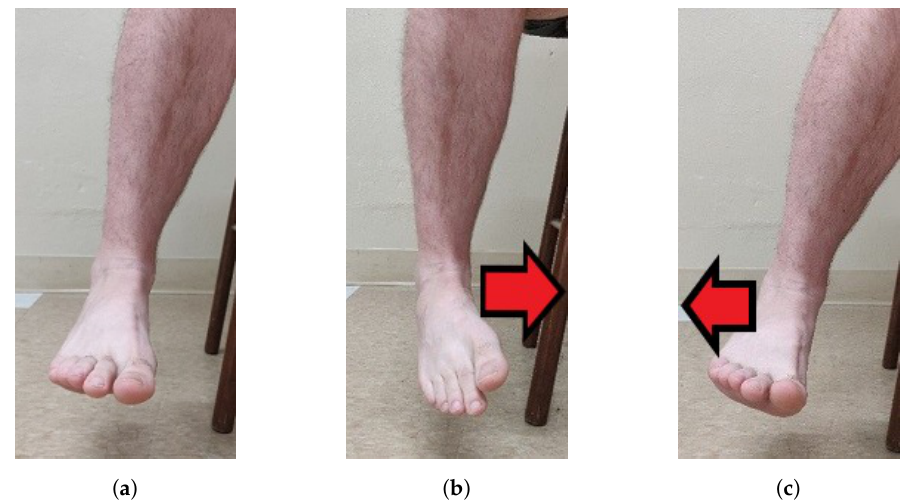
Figure 2. Frontal plane: ( a ) neutral; ( b ) inversion; and ( c ) eversion.